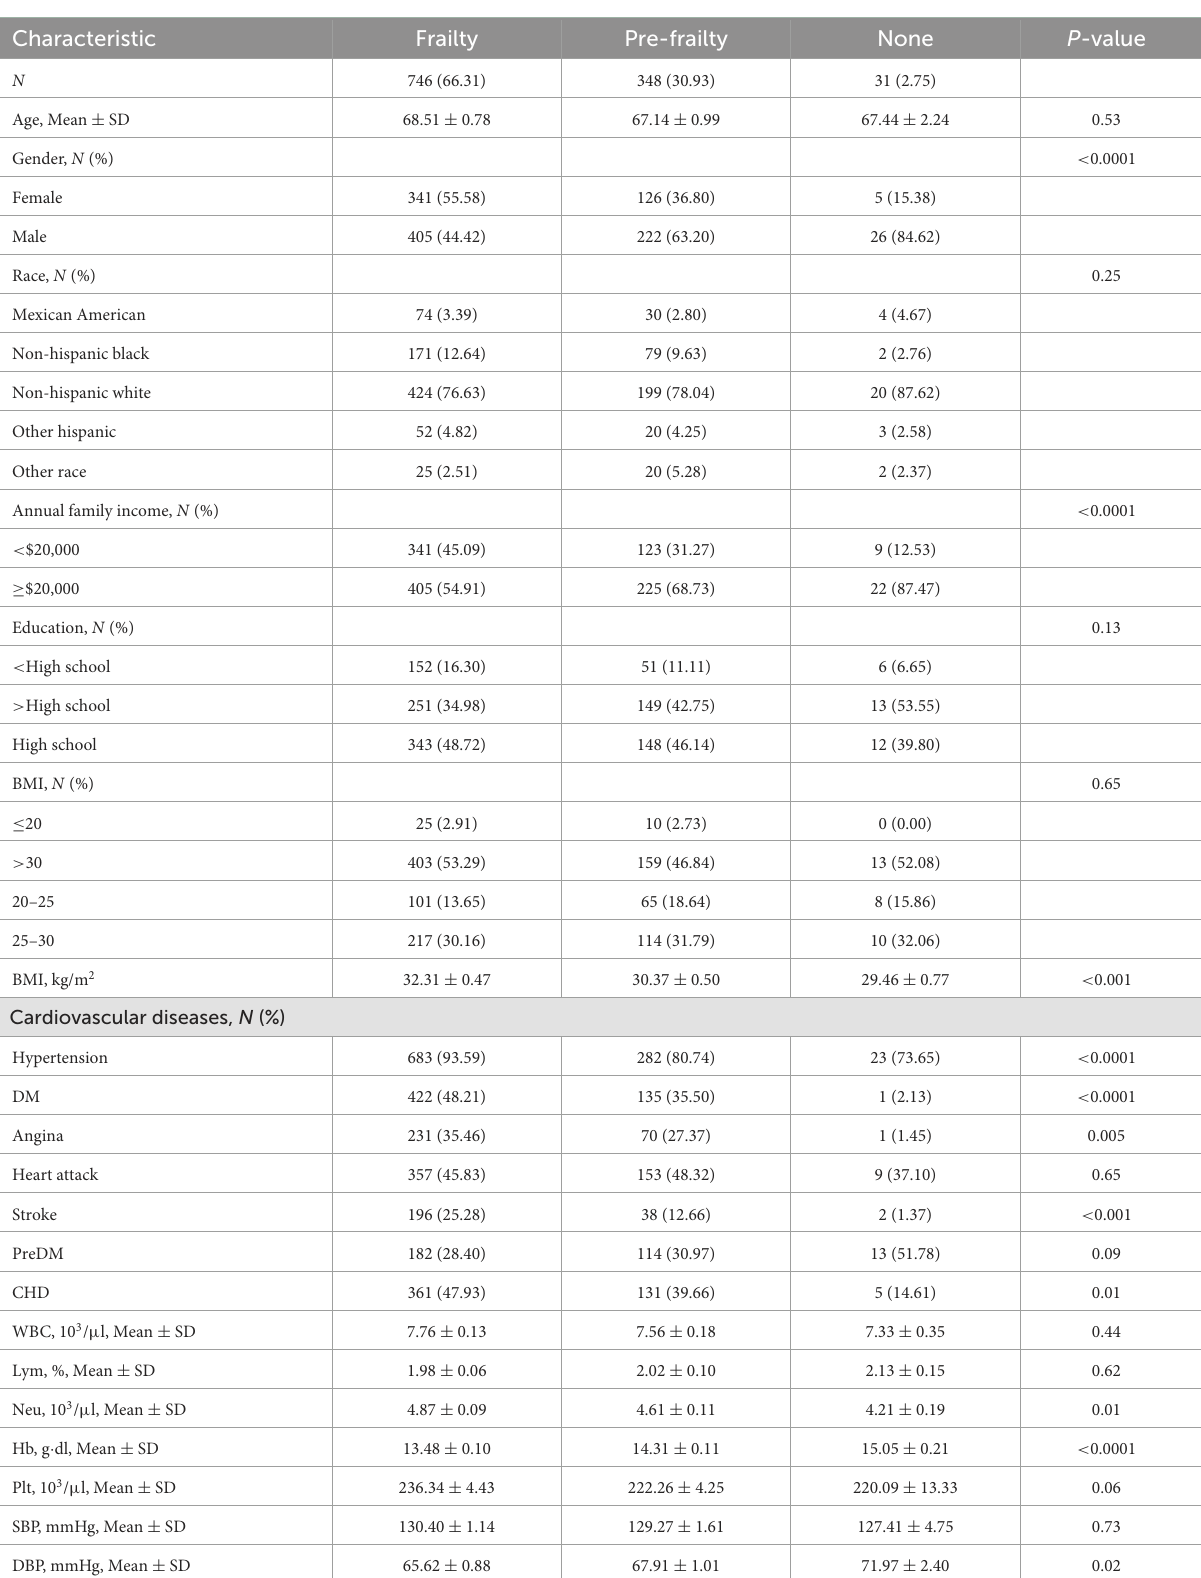
TABLE 3 Characteristics of CHF participants with frailty, pre-frailty, and non-frailty. Characteristic Frailty Pre-frailty None P